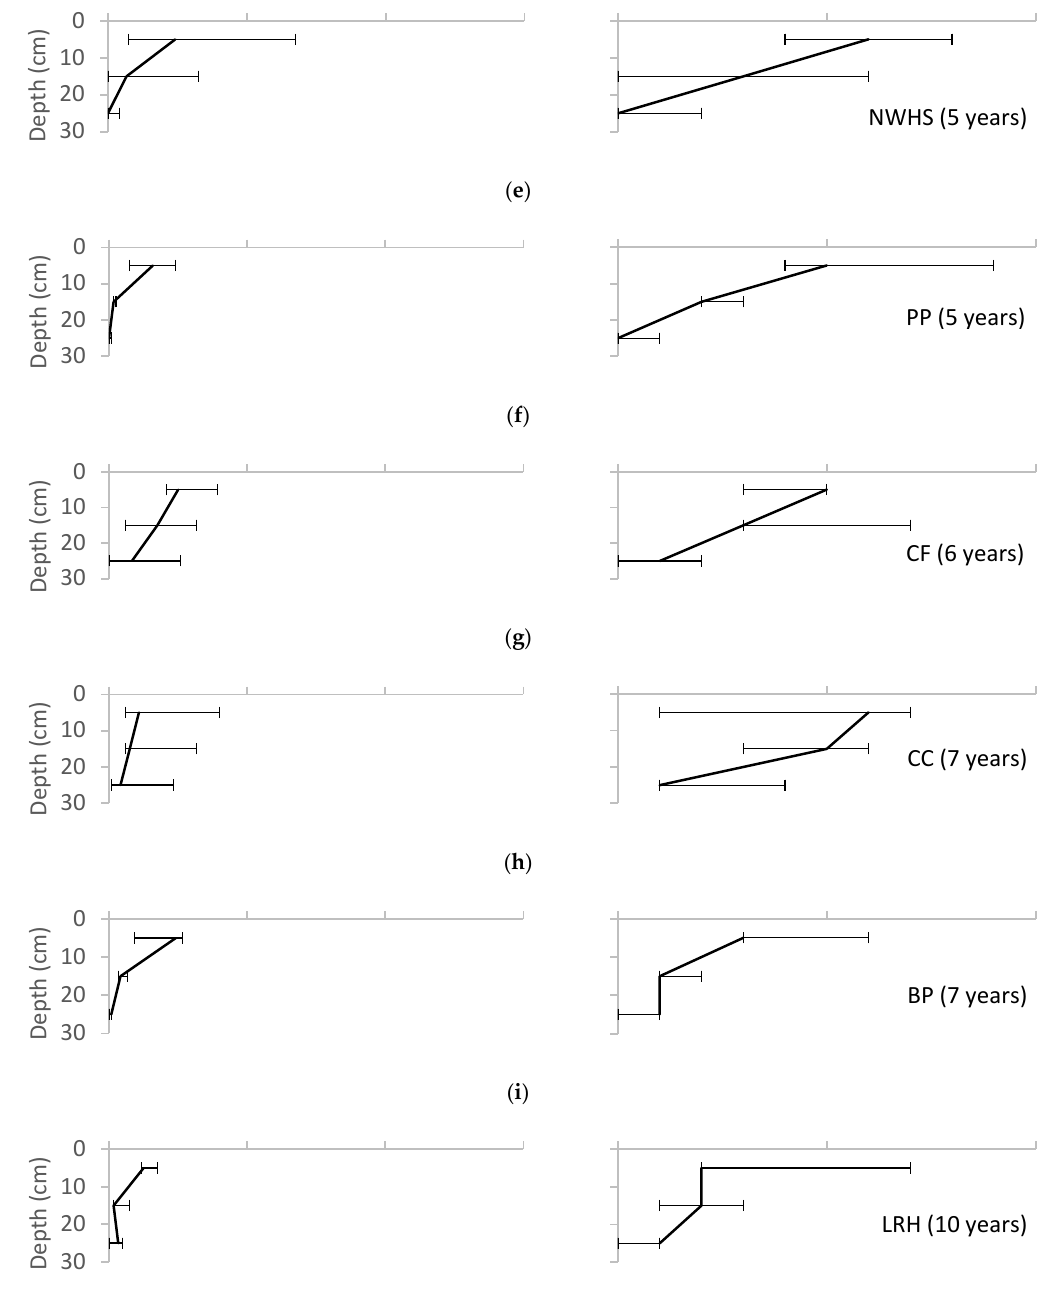
Figure 7. Variation of total animals and taxa found with depth for each of the field sites, reported as median ± range. ( a ) UMCP; ( b )WNY; ( c ) MJES; ( d ) CBF; ( e ) NWHS; ( f ) PP; ( g ) CF; ( h ) CC; ( i ) BP; ( j ) LRH.